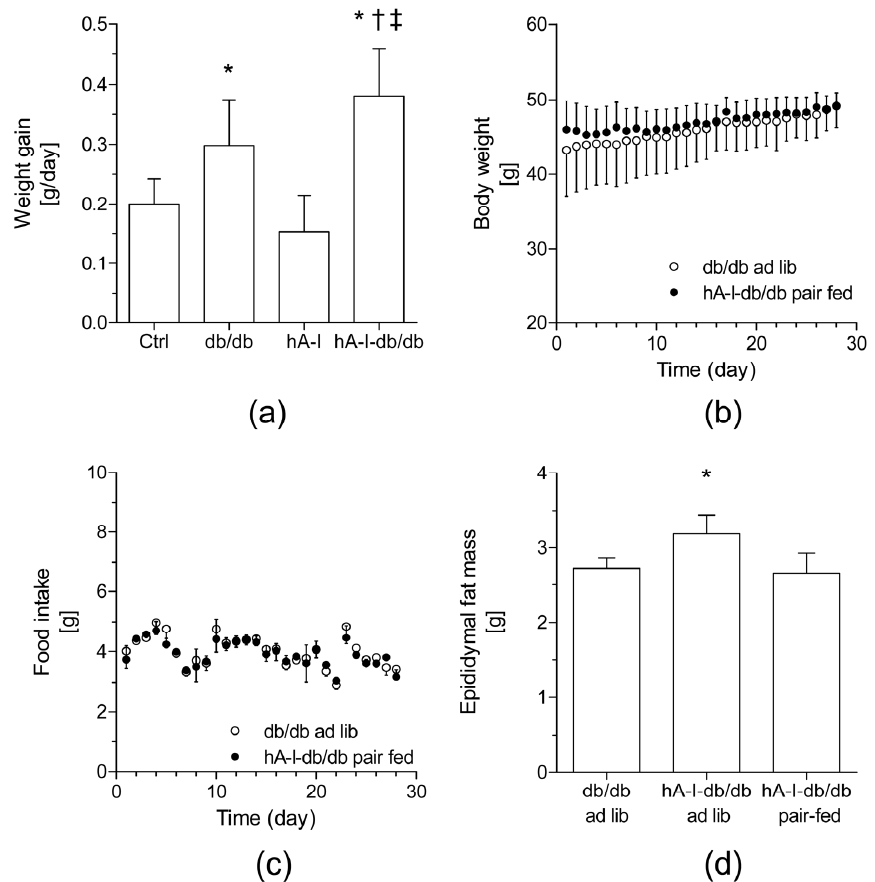
Figure 1. Overexpression of human apolipoprotein A-I (hApoA-I) increases weight gain in db/db mice. ( a ) Daily weight gain. The results are reported per gram of body weight. Means ± standard error values of data ( n = 5–8 mice/group) are graphed. Differences between mean values were assessed using the nonparametric Kruskal–Wallis test followed by Dunn’s post-test or an ANOVA followed by the Newman–Keuls post-test, as appropriate; differences were considered significant at p < 0.05. Specifically, * p < 0.05 compared with the control (Ctrl) mice, † p < 0.05 compared with db/db mice, and ‡ p < 0.05 compared with hApoA-I transgenic (hA-I) mice. ( b ) Effects of hApoA-I overexpression or pair feeding on the body weight ( b ) and food intake ( c ) of db/db mice during the 28-day treatment period. ( d ) Measurements of the epididymal fat pad in pair-fed hA-I-db/db and db/db mice. In the pair-fed group, hA-I-db/db mice were fed the same amount of diet that was consumed ad libitum by db/db mice over the preceding 24 h. Values are presented as the means ± standard error of the mean (SEM) of 3 mice. † p < 0.05 compared with the pair-fed group (db/db mice). The increase in liver triglyceride levels in db/db mice was accompanied by a concomitant induction of the expression of messenger RNAs (mRNAs) encoding markers of hepatic FFA uptake ( Cd36 : ∼ 5-fold, p < 0.05) and synthesis ( Acaca : >2-fold, p < 0.05) (Table 2). The expression of the Pparg gene ( ∼ 2-fold, p < 0.05), which specifically targets Cd36 mRNA expression [24], was also upregulated in the livers of db/db mice (Table 2). Interestingly, the relative hepatic expression of Acaca and Cd36 directly correlated with the hepatic triglyceride levels ( Acaca : Spearman’s r = +0.59; p < 0.01; Cd36 : Spearman’s r = +0.72; p < 0.01) (Figure S2e,f, Supplementary Materials). In contrast, lower expression of the Hmgcr gene, which is a main determinant of the de novo synthesis of cholesterol, was